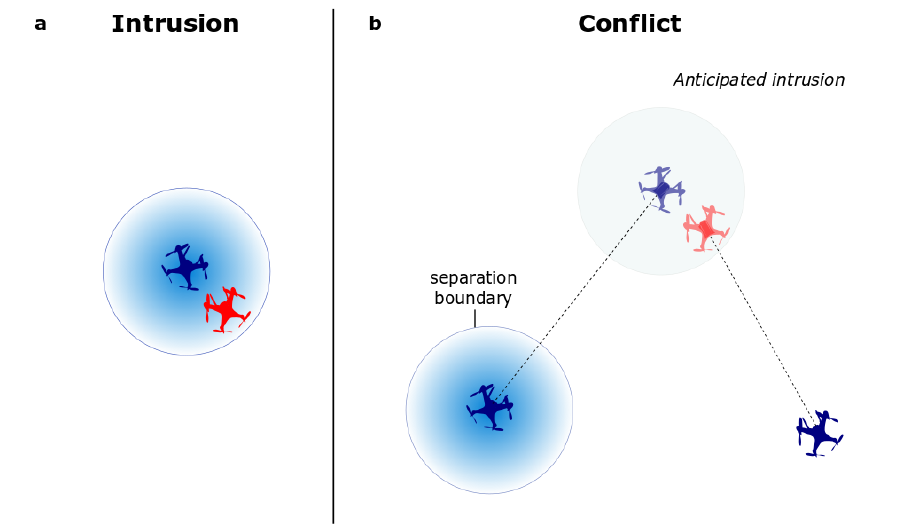
Figure 2. Difference between intrusions and conflicts between two drones in the horizontal plane. ( a ) An intrusion occurs when there is a violation of the separation boundary. ( b ) A conflict is an anticipated or predicted